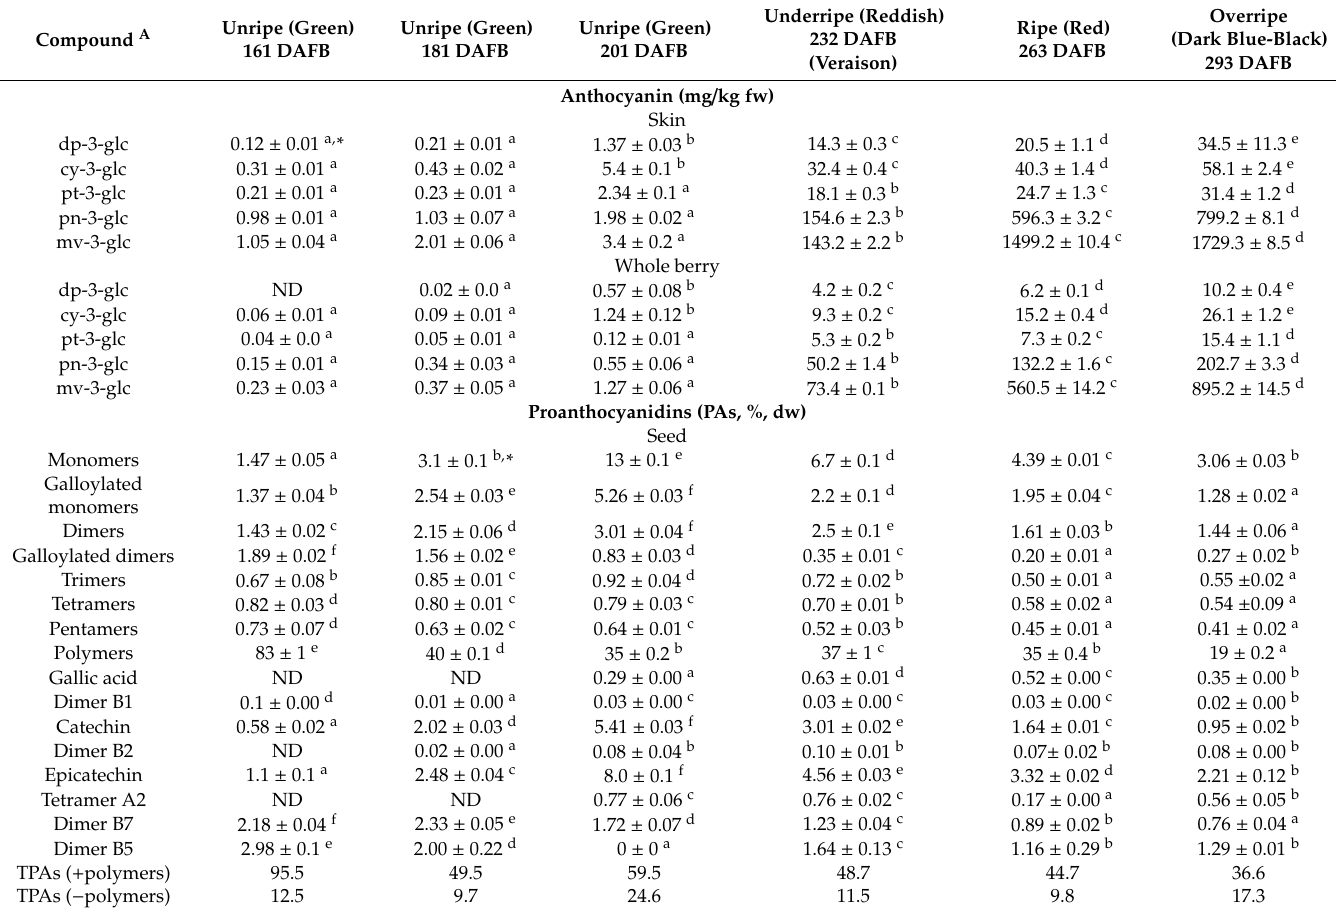
Table 2. Changes in anthocyanin contents in skin and whole berry and proanthocyanidins contents in seed in ‘Isabel’grape during berry